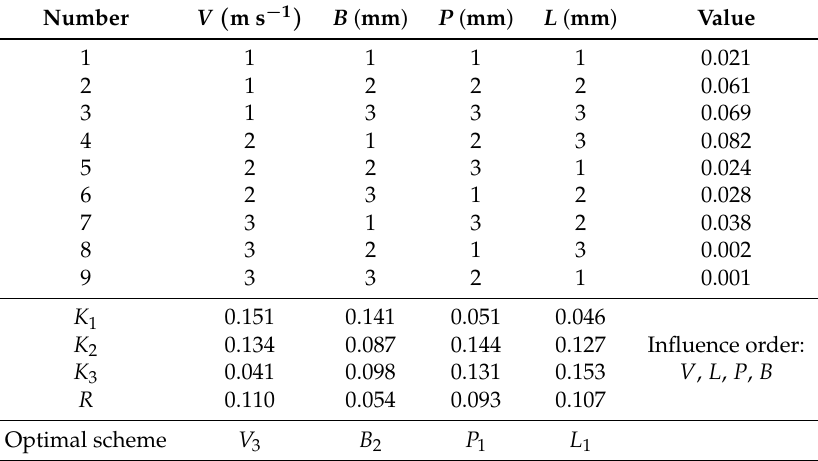
Table 3. Simulation results of index ε